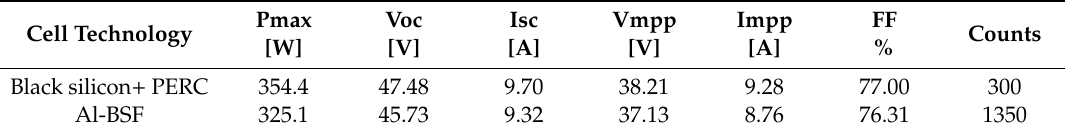
Table 1. Average values of module production.